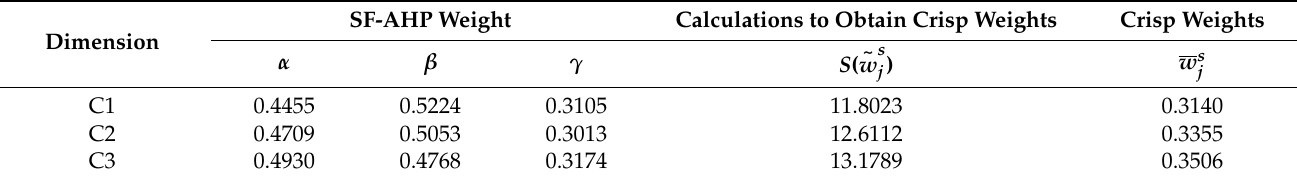
Table 10. The spherical weights from